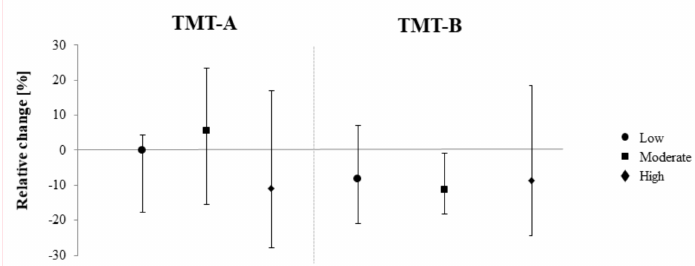
Figure 2. Pre-post di ff erences in the Stroop test as a function of exercise intensity. Figure shows medians and parameter-free 95% confidence